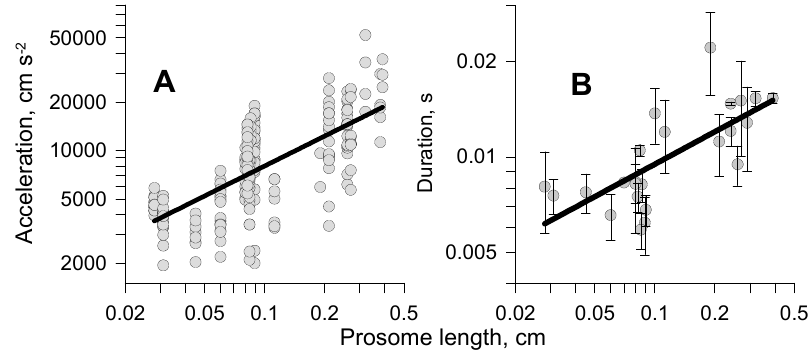
Figure 8. ( A ): Acceleration versus prosome length; a ~ L 0.62 (R 2 = 0.50). ( B ): Duration of kick; D kick = 0.021 L 0.34 (R 2 = 0.51).